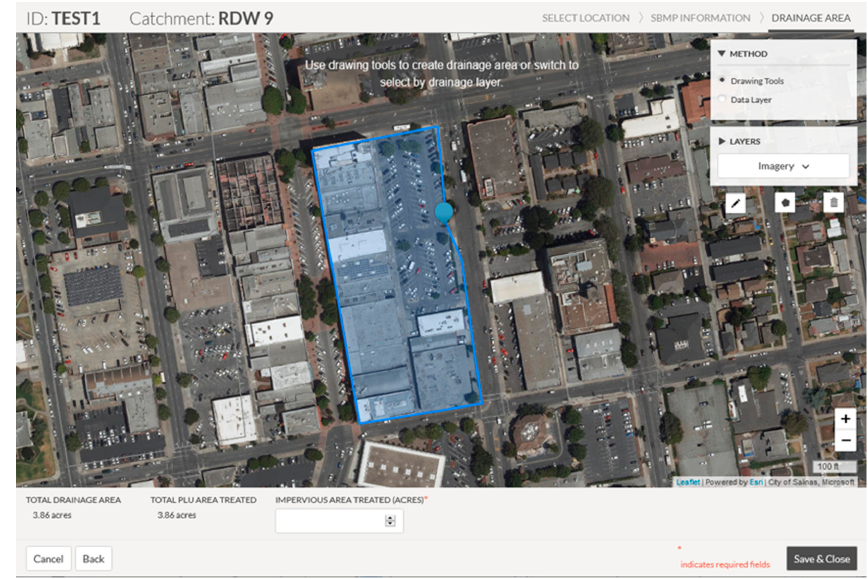
Figure 7. Web-based Green Stormwater Infrastructure (GSI) site delineation tool used in swTELR.